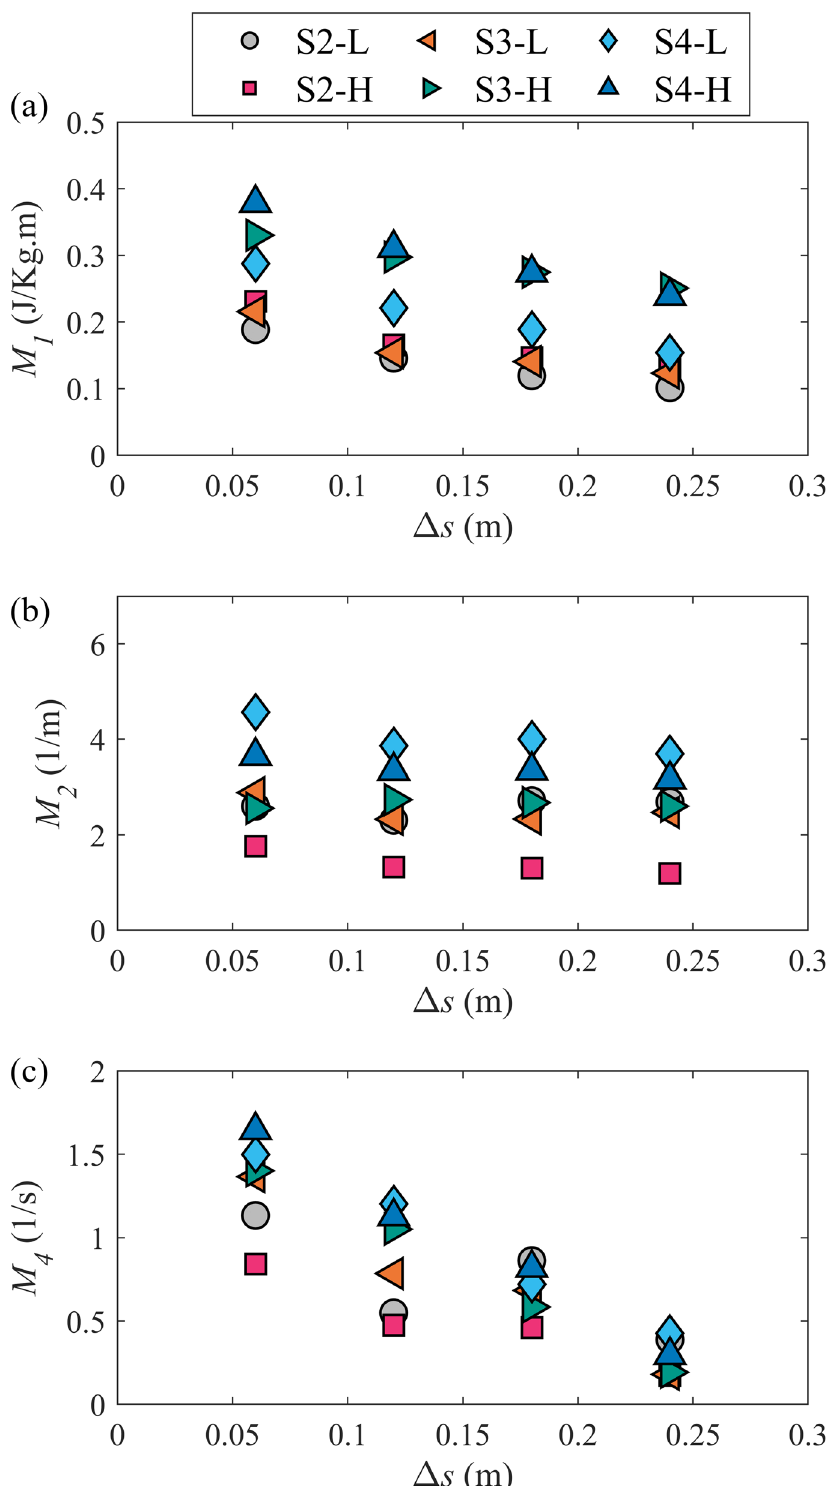
Figure 3. Variation of the habitat hydraulic complexity metrics with grid spacing (Δ s ) for scenarios with boulder placement. ( a ) kinetic energy gradient metric, M 1 , ( b ) normalized kinetic energy gradient metric, M 2 , ( c ) modified recirculation metric M 4